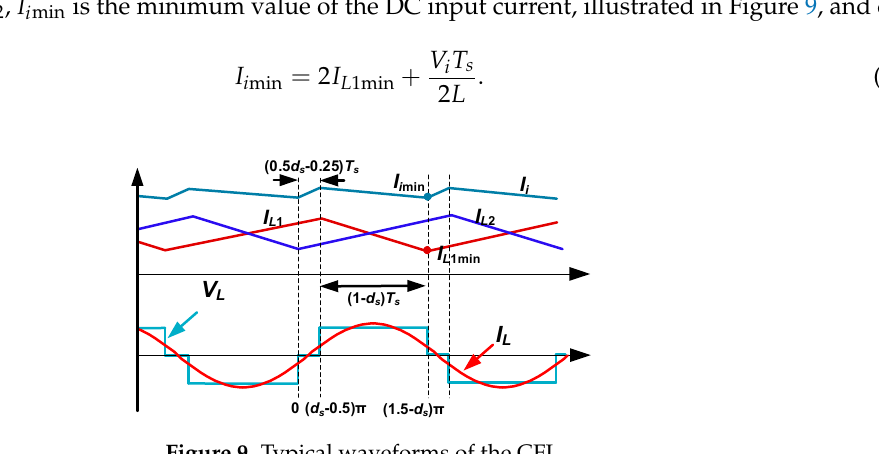
Figure 9. Typical waveforms of the CFI.